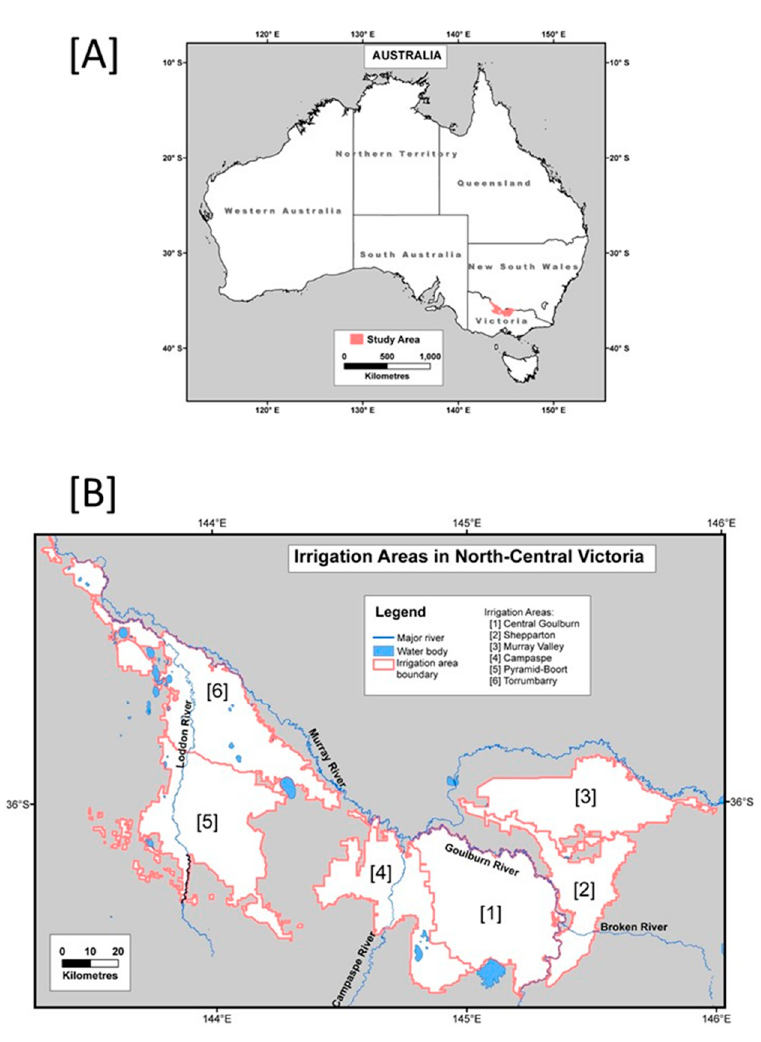
Figure 1. Map of the study area. ( A ) Location of the study area in Australia; ( B ) Map showing irrigation areas (sub-regions) in North-Central Victoria.